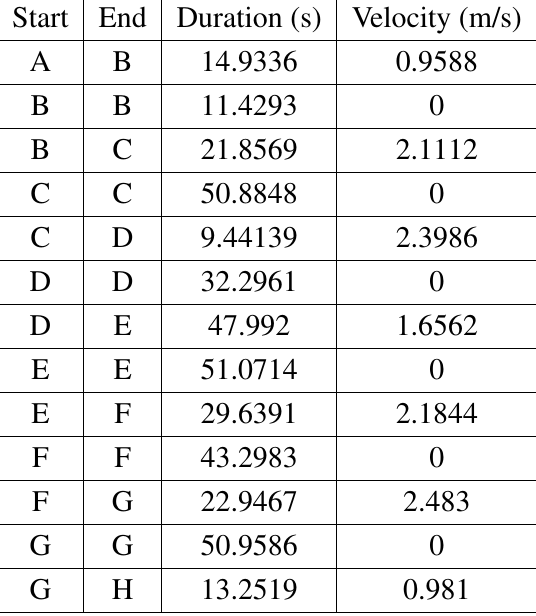
Table 3. The user motion parameters for feasibility analysis in a WLAN